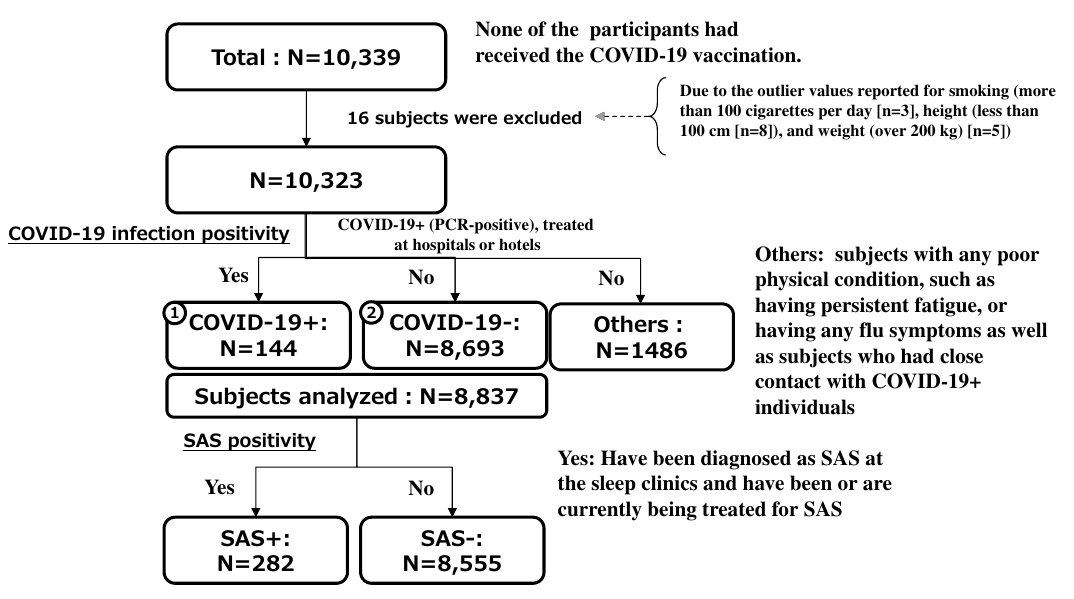
Figure 1. Flow chart for inclusion and exclusion of the